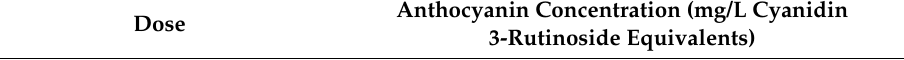
Table 2. Concentrations of total anthocyanins corresponding to the doses of FW used in cell culture viability experiments, calculated from the concentrations in V3, V4 and V5 in Table 1.